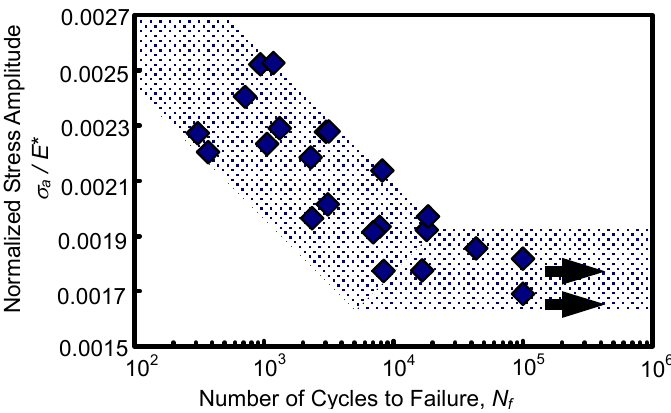
Fig. 5. S-N relationship for bovine cortical bone. (E* = 20.9 - 29.5